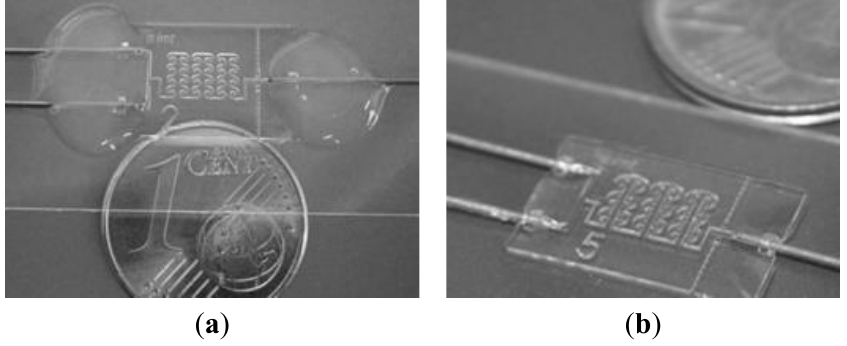
Figure 8. Pictures of the microfabricated semi-circle ( a ) and Ω ( b )